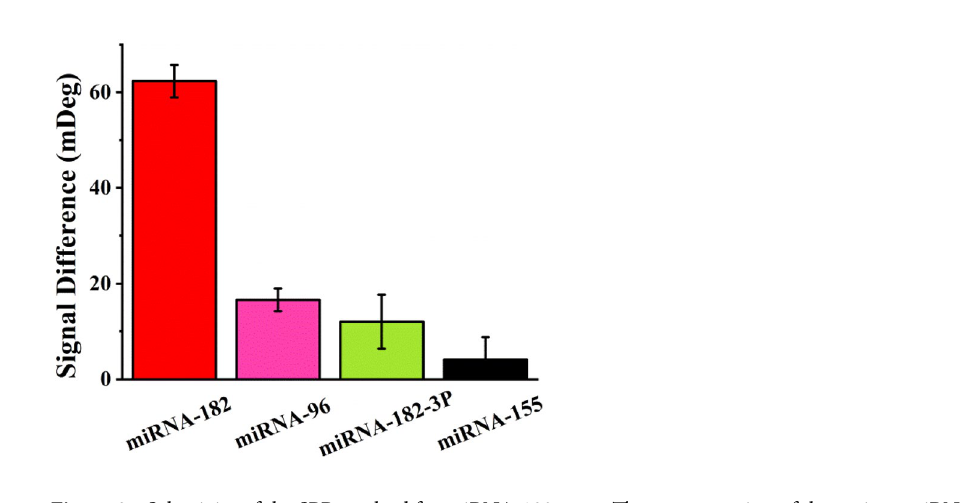
Figure 3. Selectivity of the SPR method for miRNA-182 assay. The concentration of the various miRNA species was maintained at 50 pM. The error bars indicated the standard deviation of three repeated